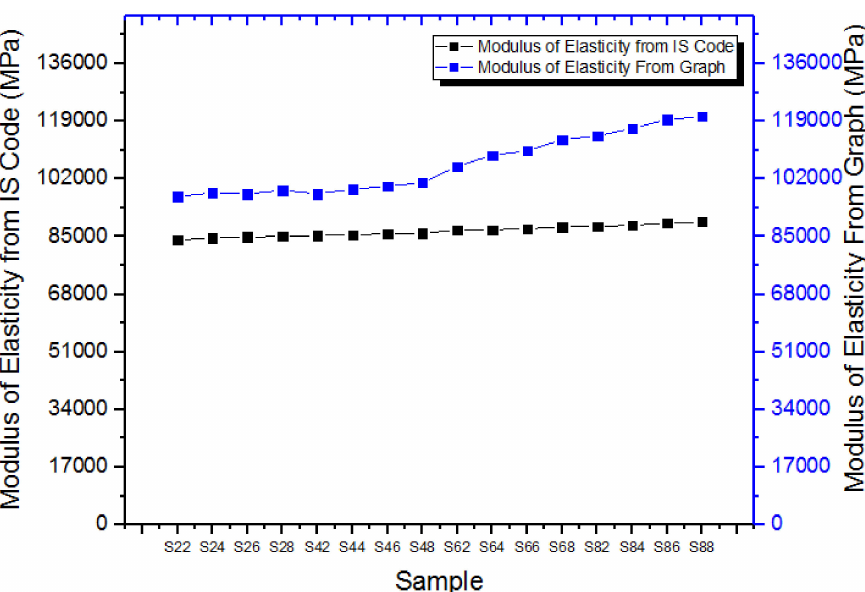
Figure 16. Modulus of elasticity